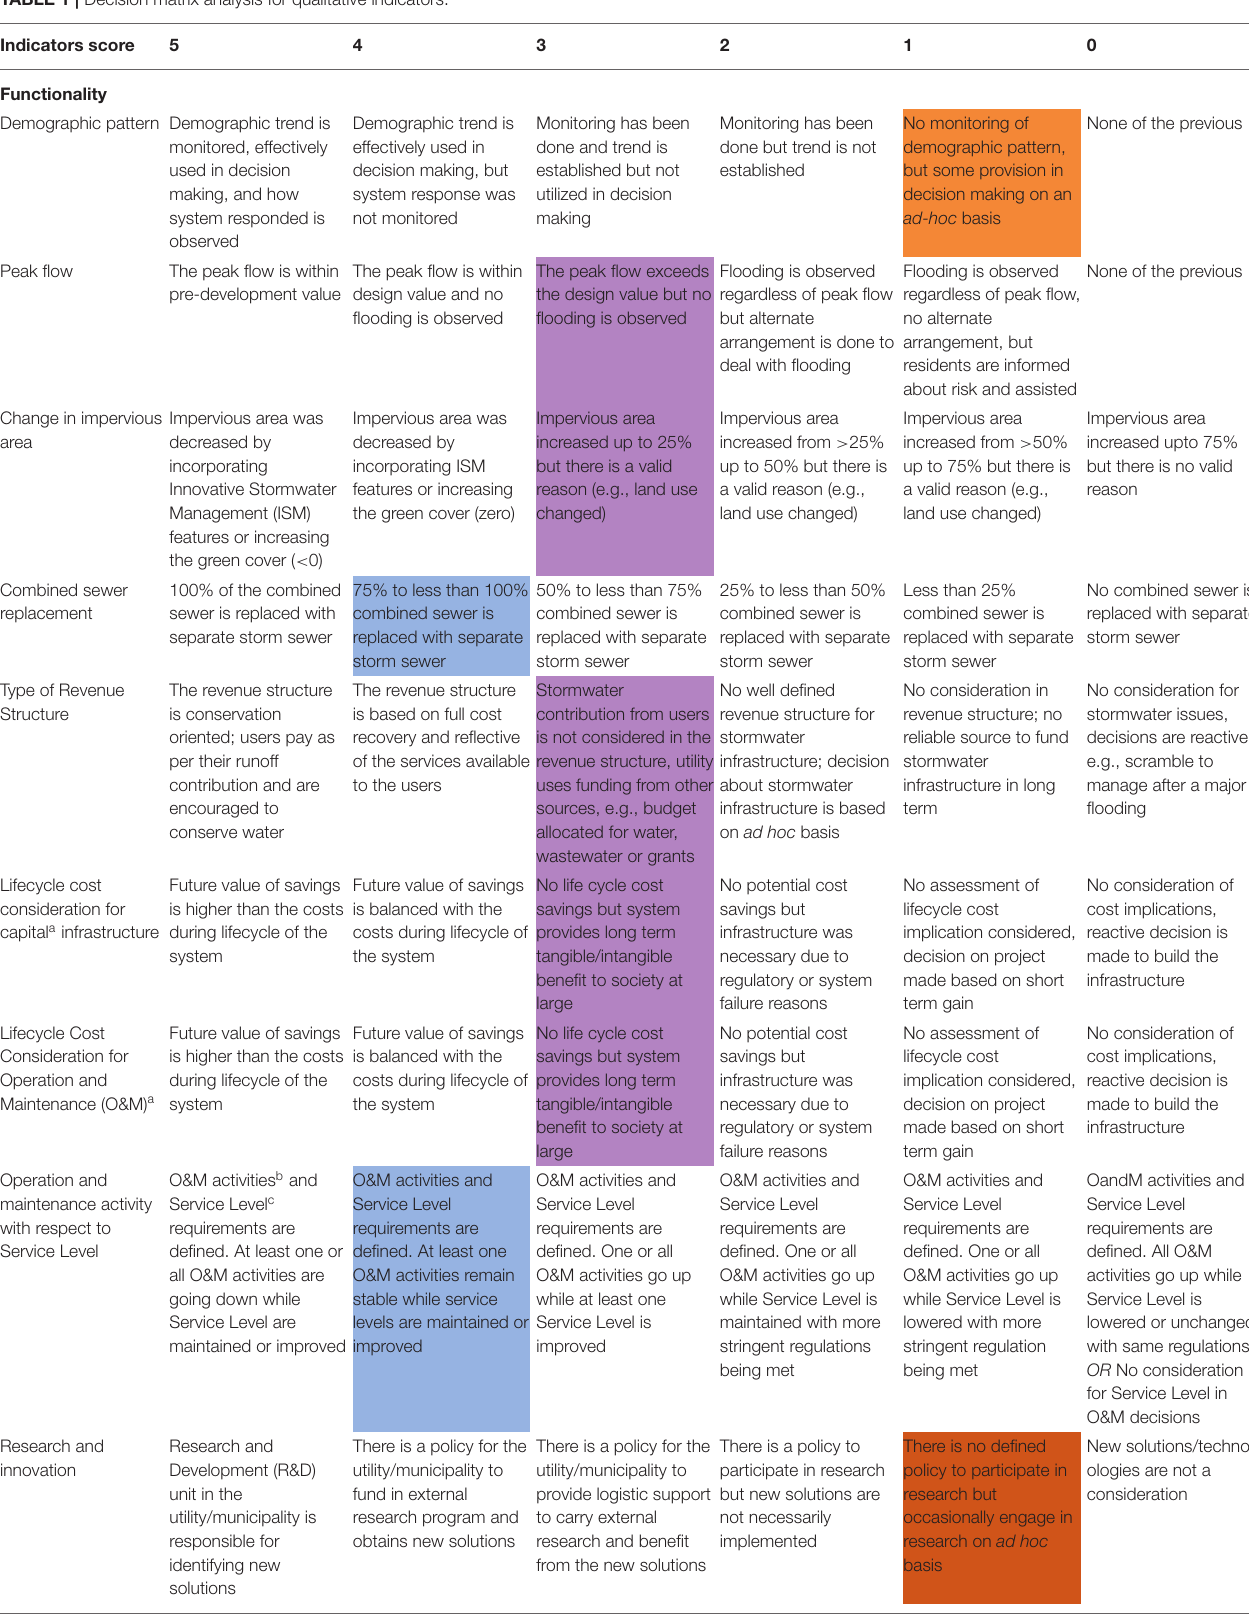
TABLE 1 | Decision matrix analysis for qualitative indicators. Indicators